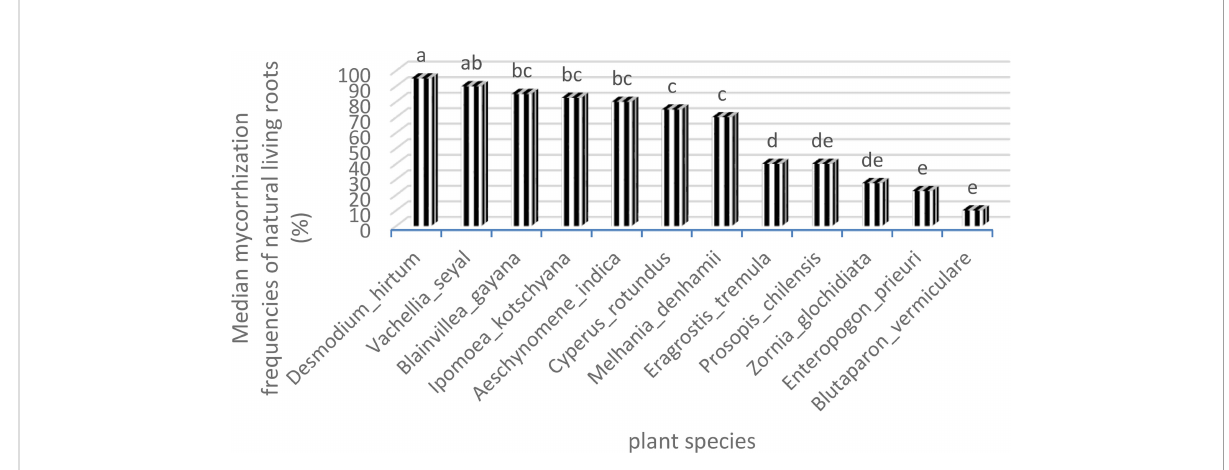
FIGURE 8 Frequencies of mycorrhization of natural living roots. Means with identical letters are statistically equivalent at the 5%